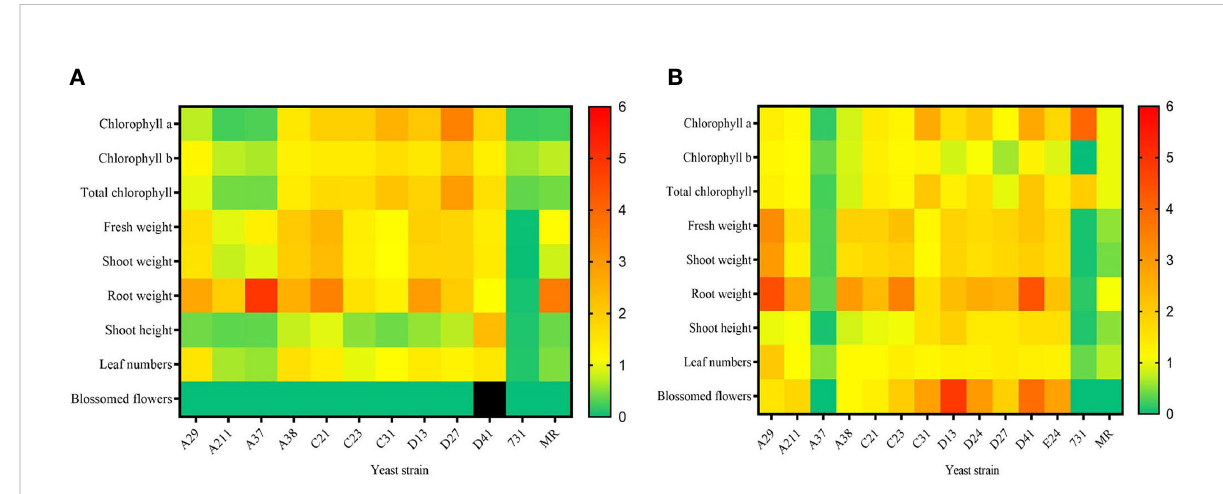
FIGURE 6 The effect of mVOCs produced by yeasts on plant growth at varying temperatures. (A) effect at 10°C; (B) effect at 20°C. X-axis indicates yeast strains; Y-axis indicates parameter folds compared to blank control; n=10; yellow indicates no difference (=1); green indicate inhibition (<1); orange and red indicate promotion (>1); black indicates strong promotion of plant growth (11.11 folds compared with